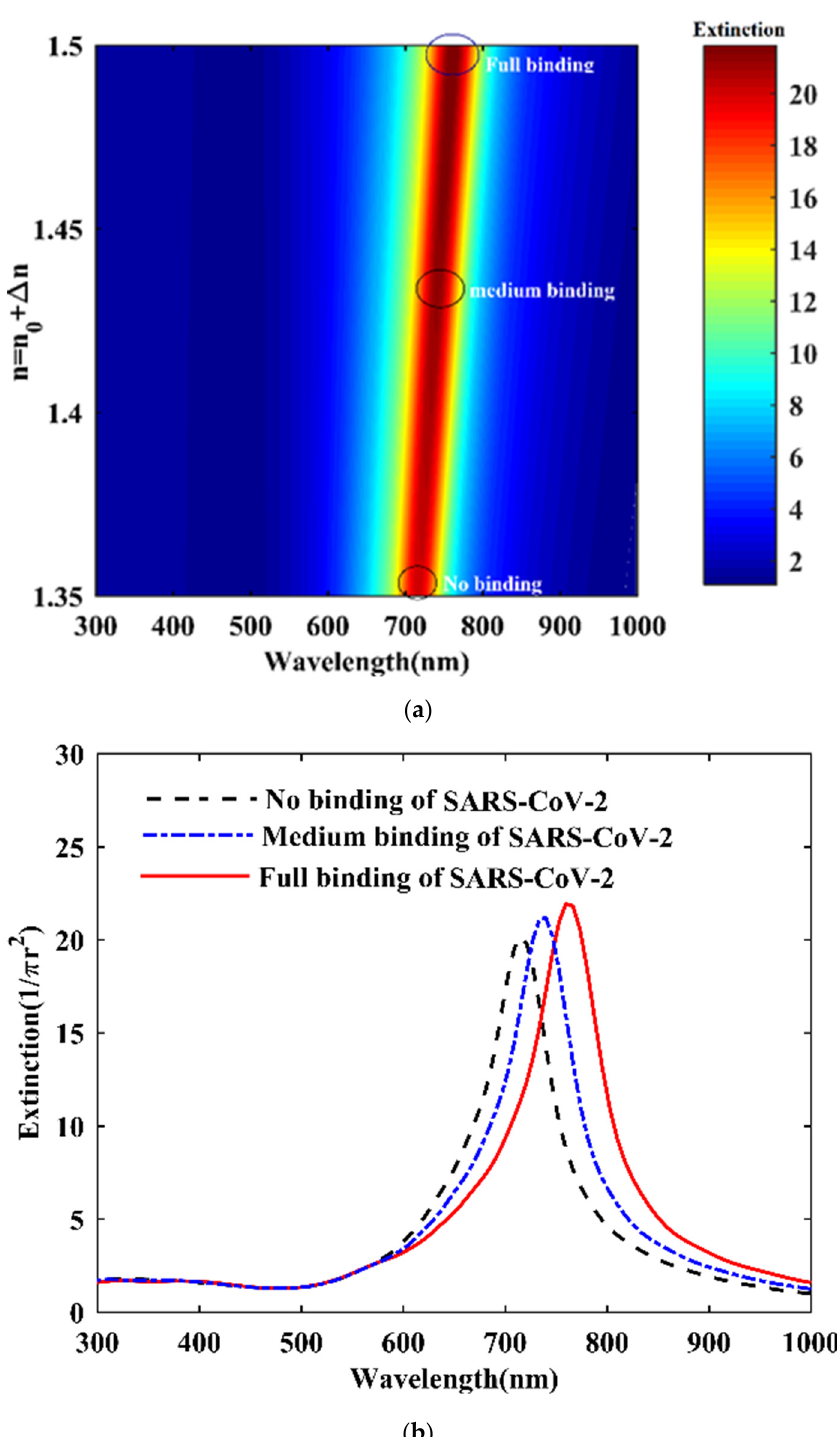
Figure 6. ( a ) Contour plot of extinction versus wavelength and refractive index of environment. ( b ) Comparison of the extinction as a function of wavelength for three cases of SARS-CoV-2 concentration (no binding, medium binding, and full binding).